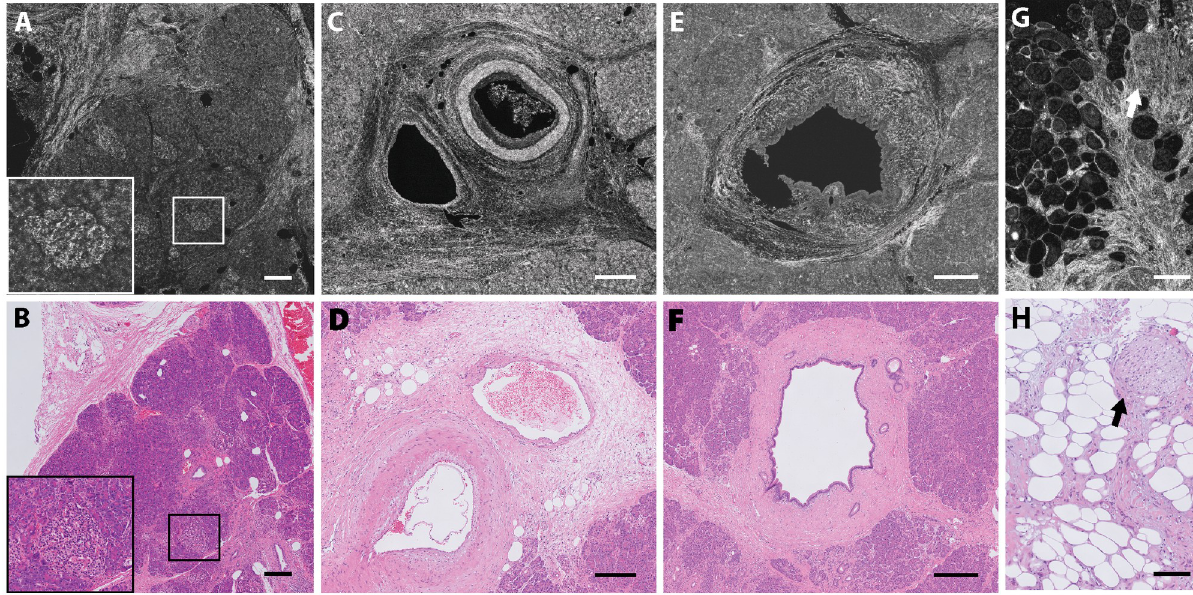
Fig 2. Examples of FF-OCT images of normal pancreatic tissue and corresponding histology. Structures that are easily identifiedon FF-OCT images includenormal pancreaticparenchyma (A-B), vessels (C-D), and a large pancreaticduct (E-F). Harder to recognizeare nerve bundles(G-H). Scale bars, 250 μ m (A-B, G-H), and 150 μ m (C-F). Inset shows an islet of Langerhans(A-B) at 2.5 times higher magnification.